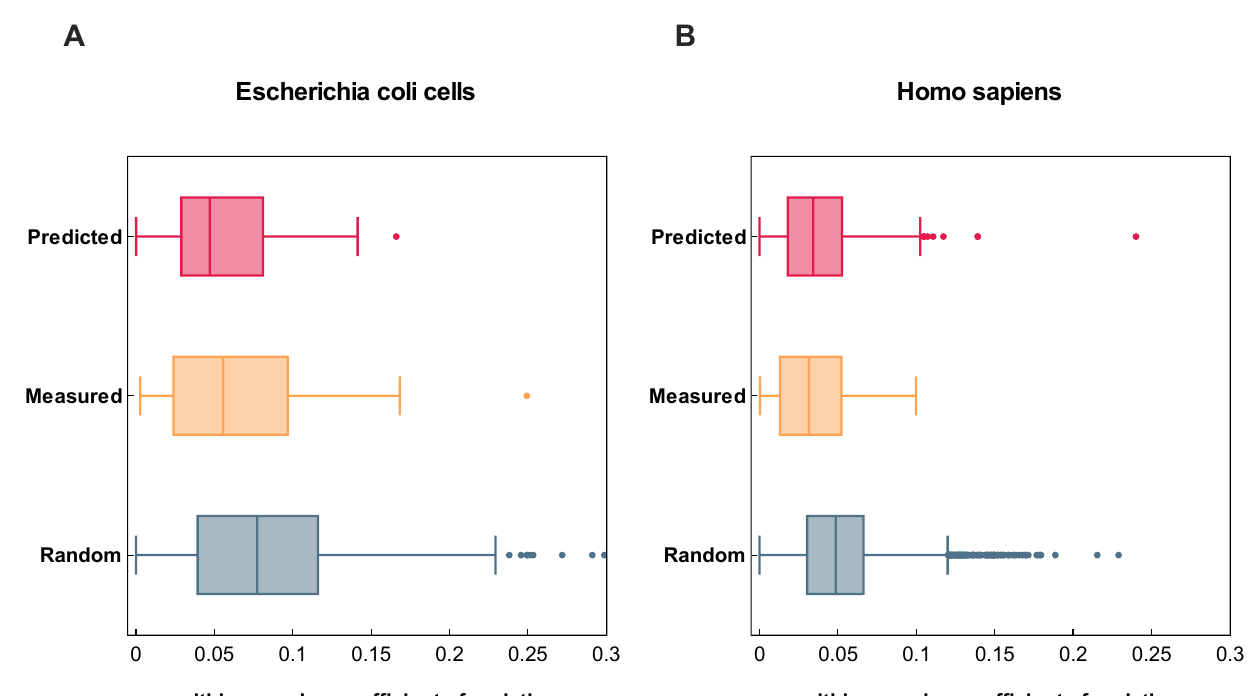
Figure 4. Variation of measured and predicted melting temperatures ( T m s) of protein complexes and randomly grouped proteins of E. coli ( A ) and Homo sapiens ( B ). The calculated coefficient of variation based on analysis of measured and predicted T m s show a solid agreement for both organisms. As previously described in the analysis of thermal proteome profiling data, both reflect the tendency that proteins present in protein complexes show a lower variation in thermostability when compared to randomly grouped proteins.